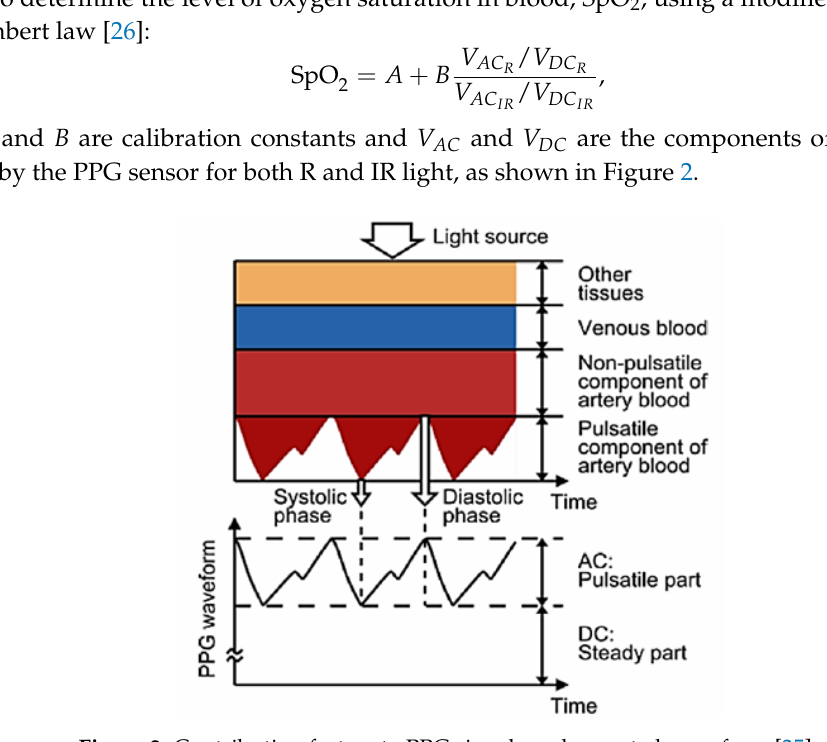
Figure 2. Contributing factors to PPG signals and expected waveform